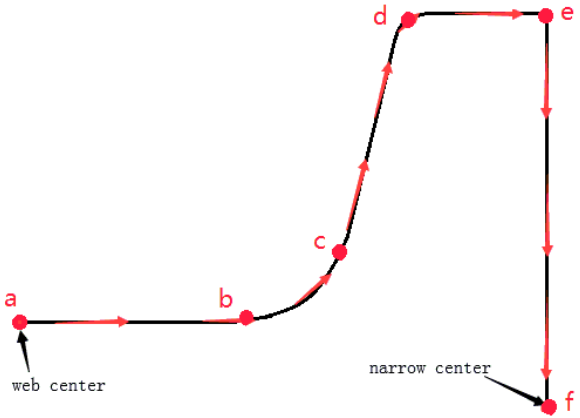
Figure 12. Peripheral diagram of a quarter of the beam blank.